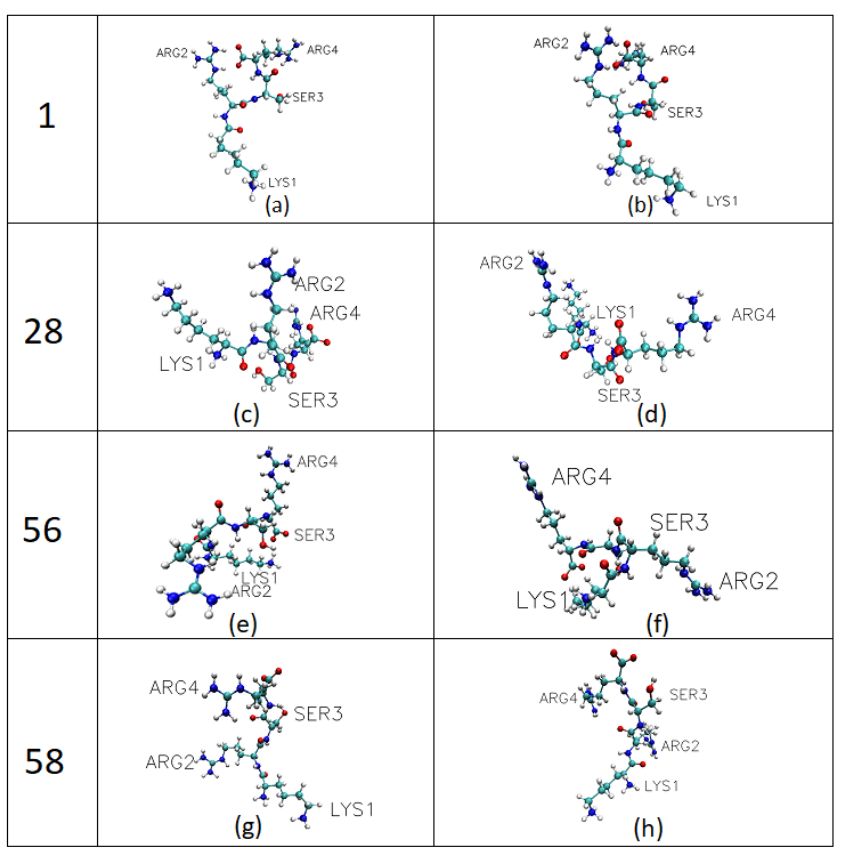
Figure 4. Molecular conformations of the KRSR peptide viewed from two different angles. The four most prevalent conformations identified by REMD simulations are shown. ( a , b ) are views from different directions of KRSR conformation cluster number 1, ( c , d ) are views of cluster number 28, ( e , f ) shows the conformation of cluster number 56 and ( g , h ) belongs to conformation of cluster number 58. Visualization was done with VMD 1.9.3 in CPK representation.